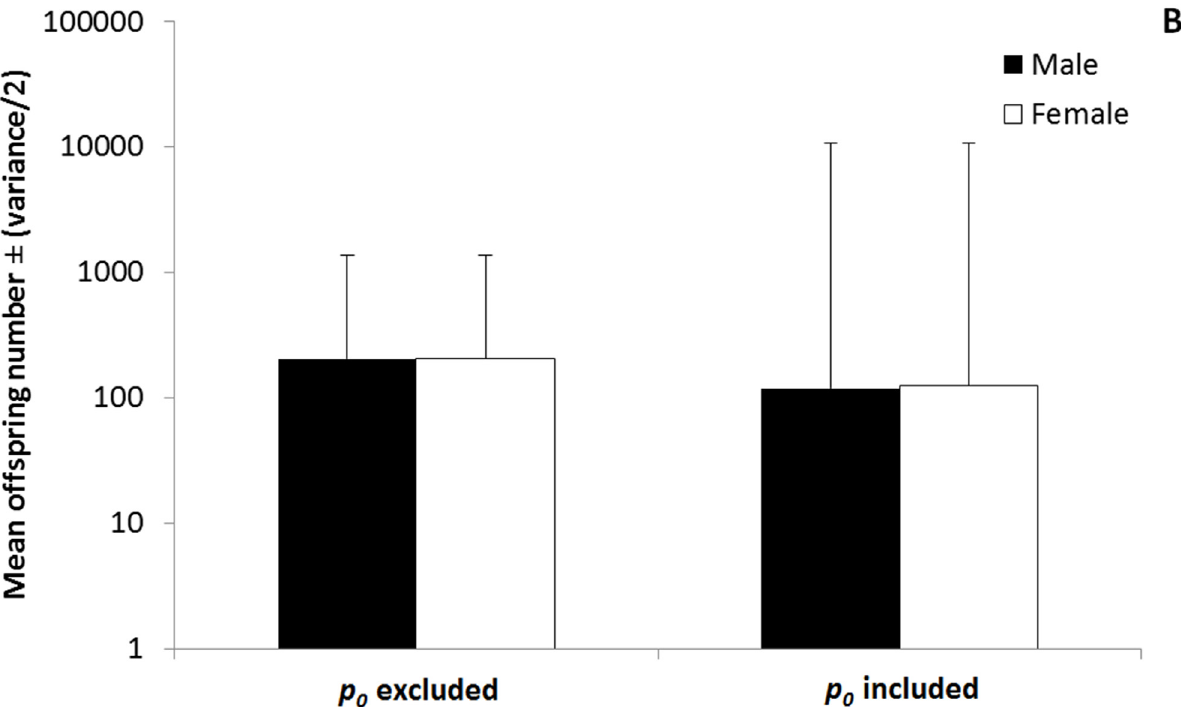
Fig 2. The effect of excluding and including the zero class of individuals ( p 0 ). When the mean and variance in fitness are estimated using offspring numbers, for males (black bars) and for females (white bars), including the fraction of the population that fails to produce offspring ( p 0males ; p 0females ) causes the average fitness to decrease and the variance in fitness to increase; The error bars represent one half of the variance in fitness; only positive values are included; the Y-axis is measured using a logarithmic